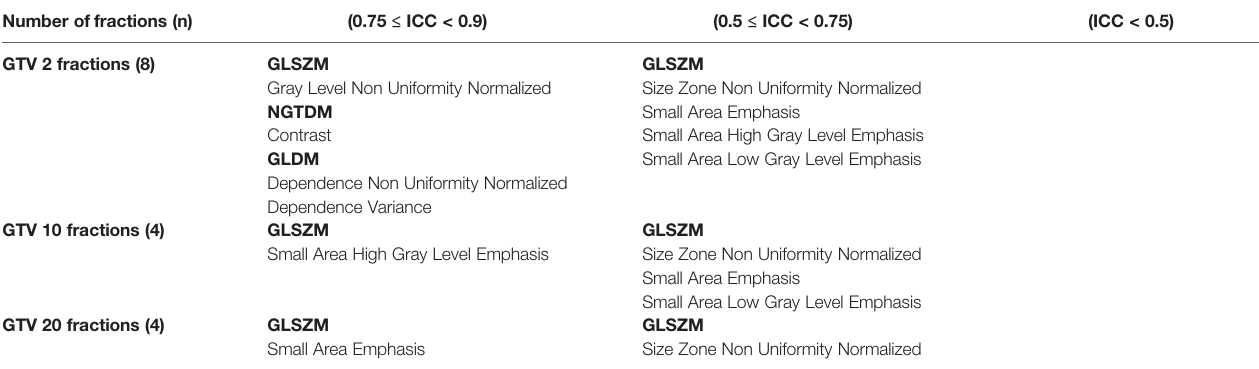
TABLE 1 | Features that had ICC < 0.9 are shown for different ROIs and different numbers of fractions. Number of fractions (n)